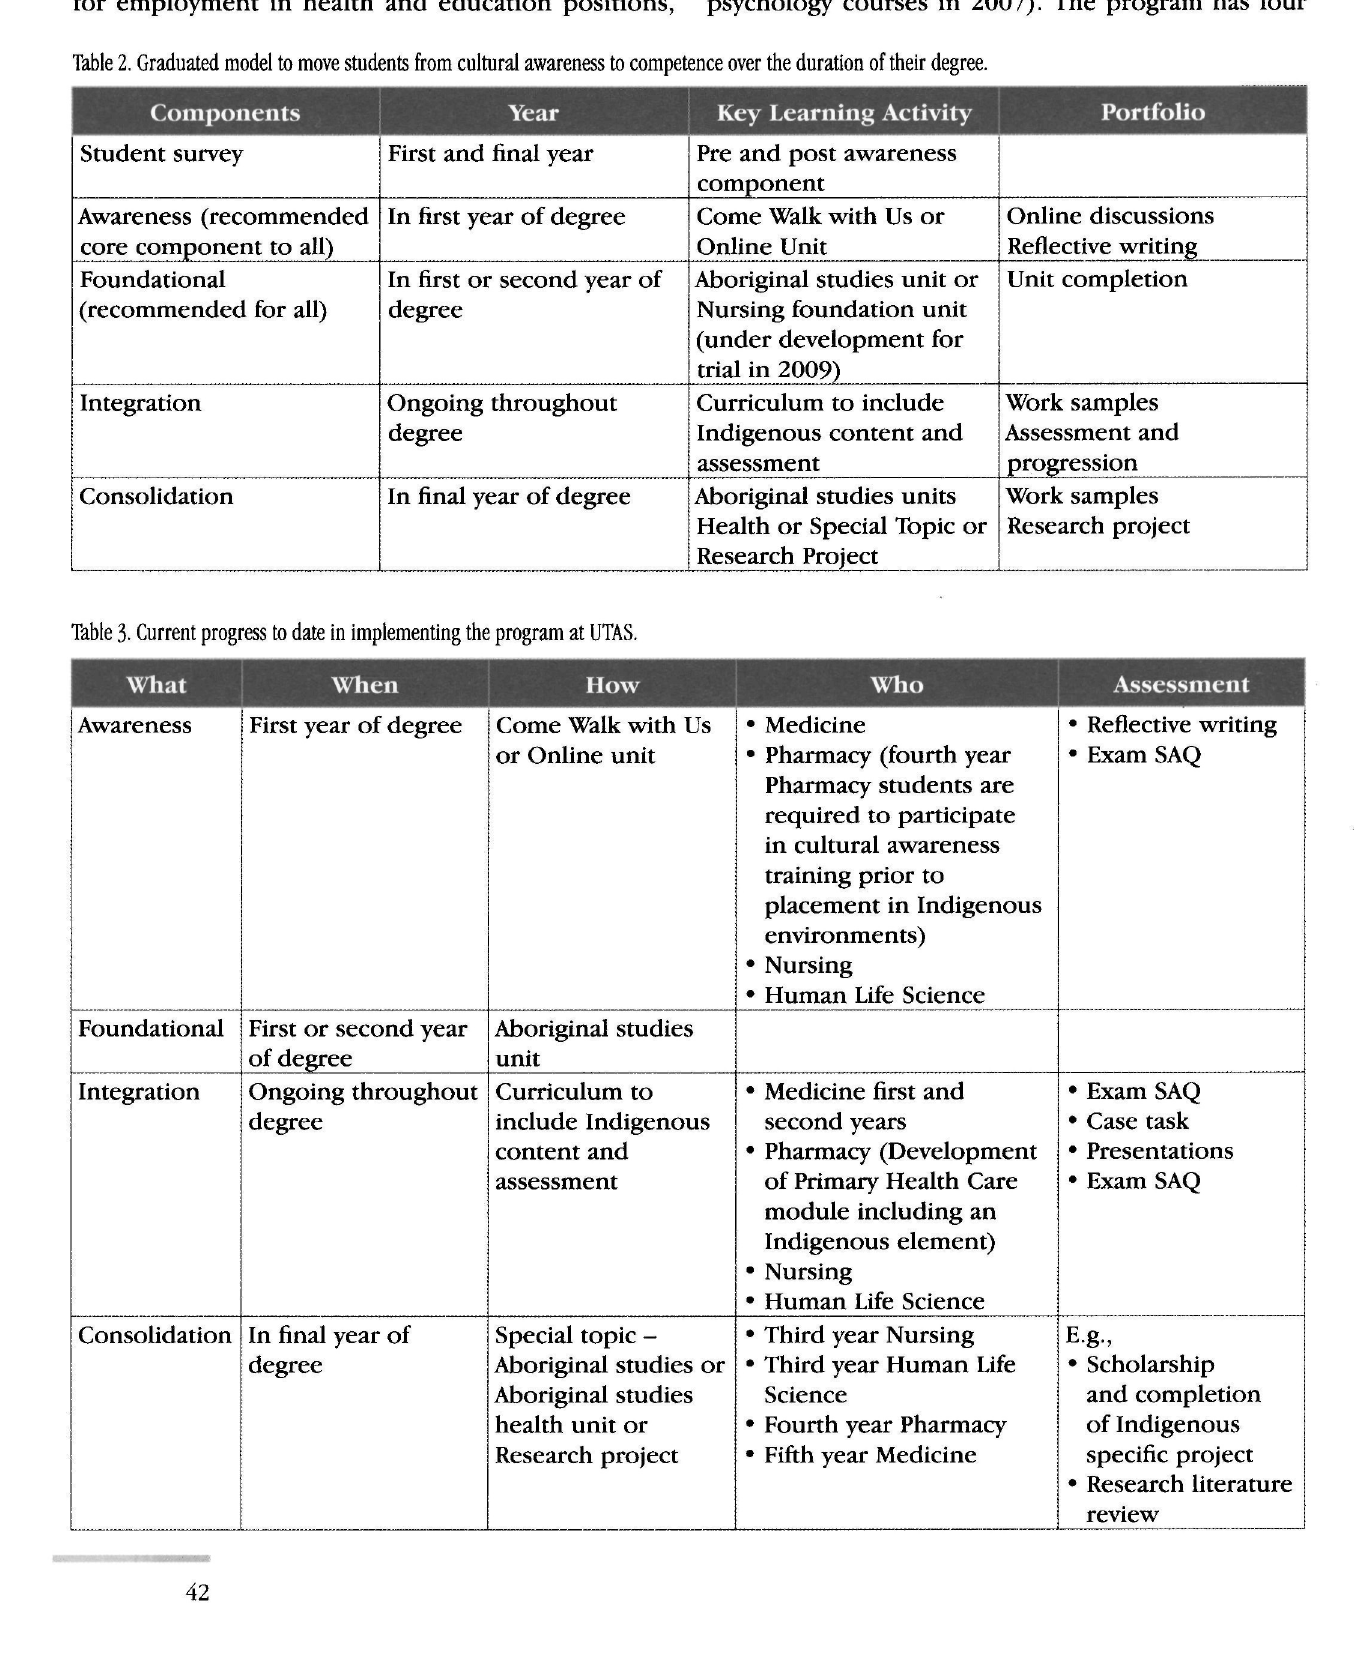
Foundational Integration